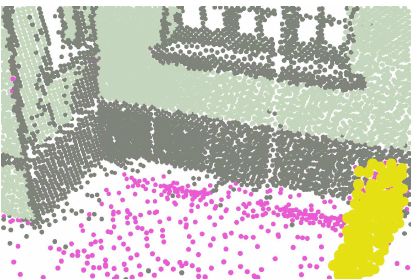
Figure 10. Example of a low point density ground segment, falsely classified as undefined (UD = magenta).